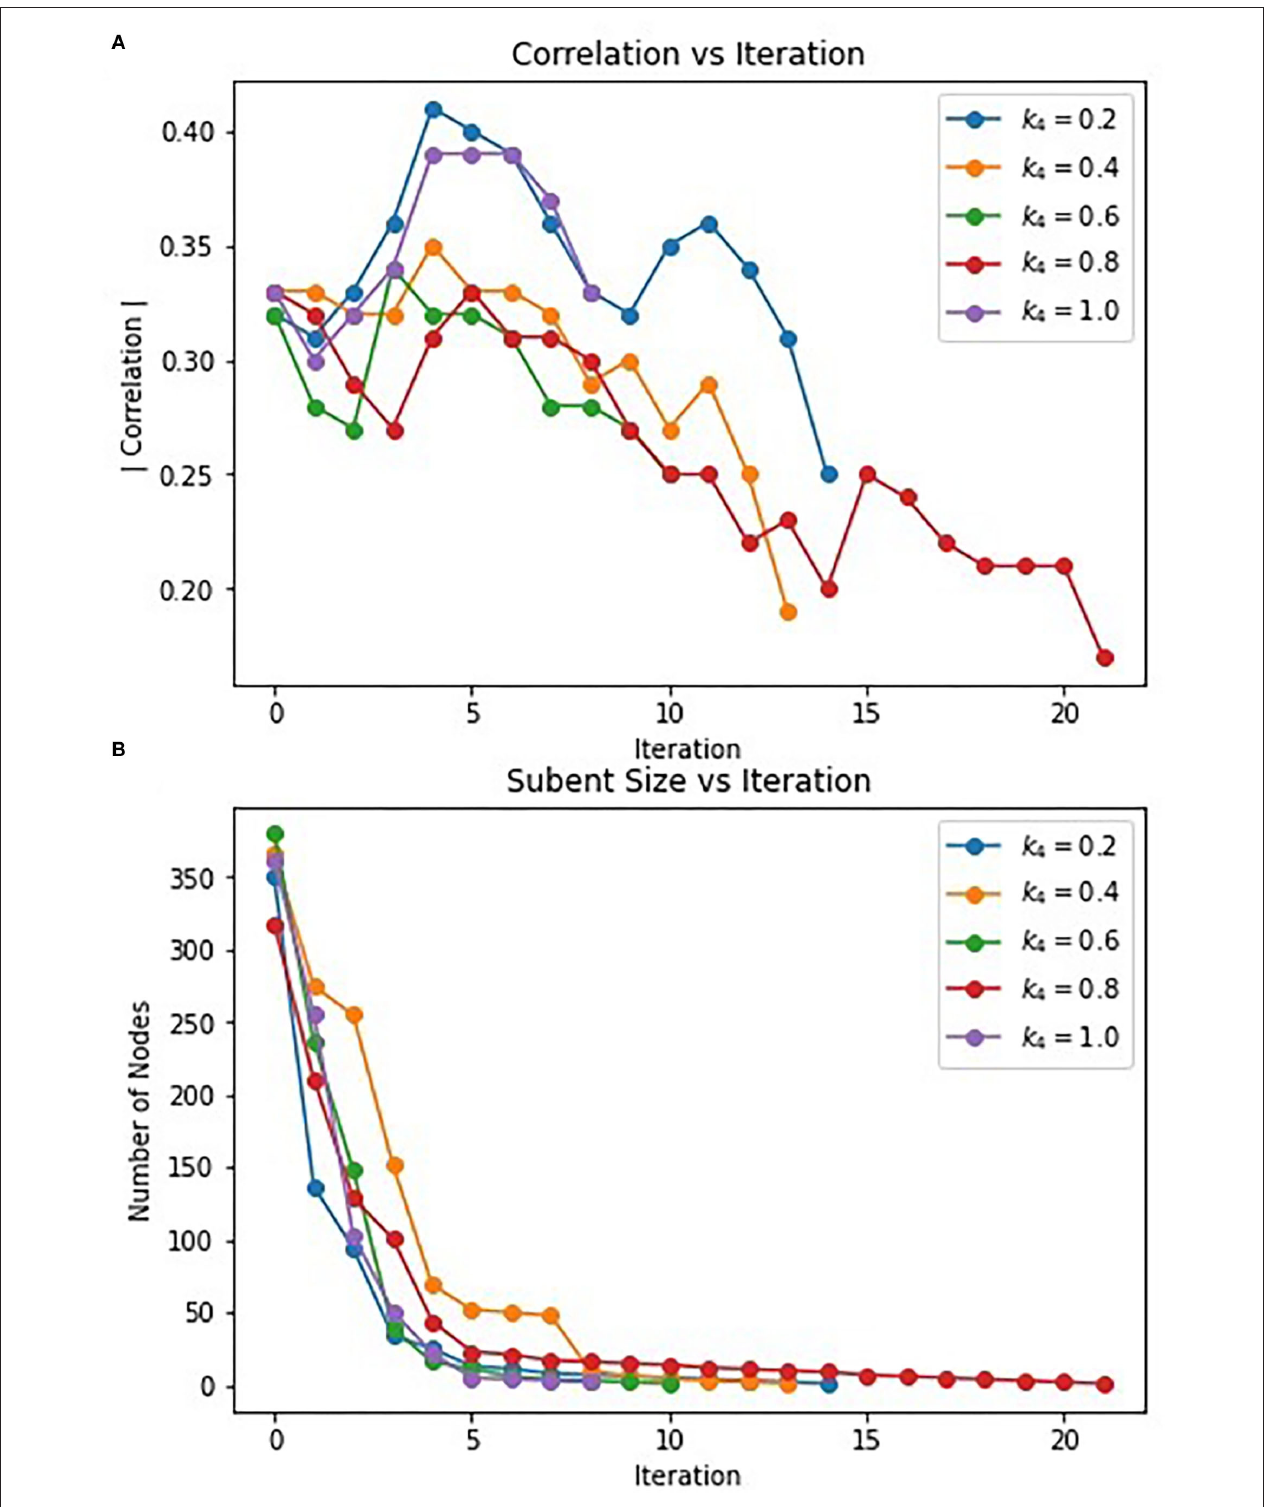
FIGURE 6 | Change in correlation (A) and subnet size (B) of subnets produced by PageRank in each iteration.